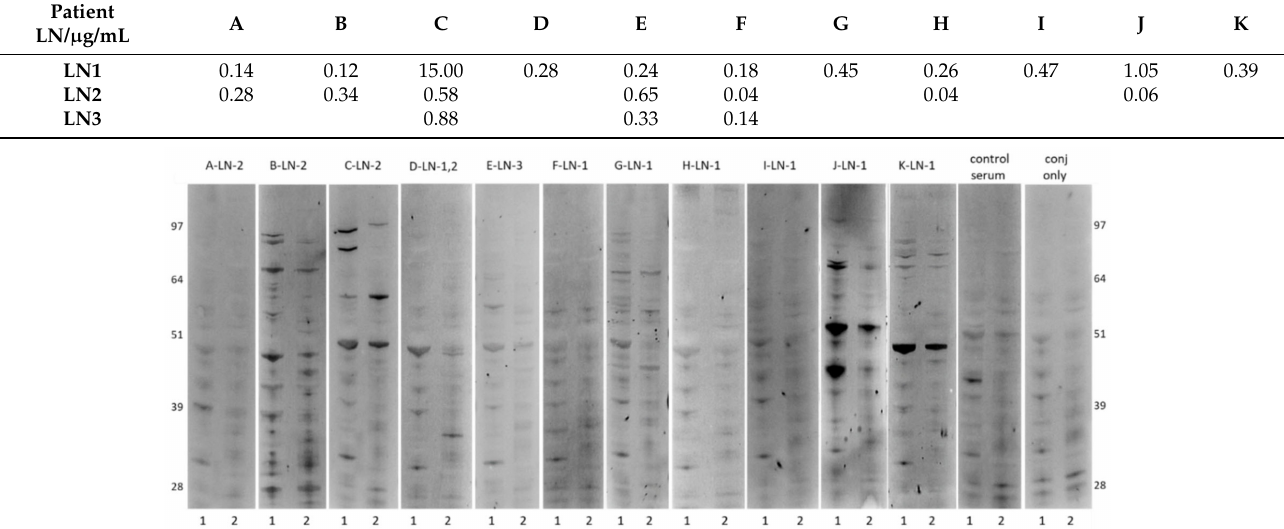
Figure 1. Western blots of soluble (1) and insoluble (2) fractions of OVCAR3 cell extracts, screened with selected ASC probes from 11 ovarian cancer patients (A–K). Molecular weight markers on the far left and right are recorded from pre-stained markers. Control lanes on the right are screened with serum from healthy women (control serum) or secondary antibody conjugate only (conj